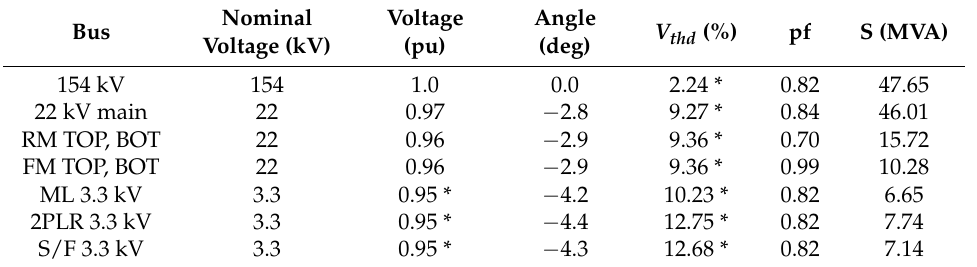
Table 5. ESA calculation results for load flow, V thd , and power factors without